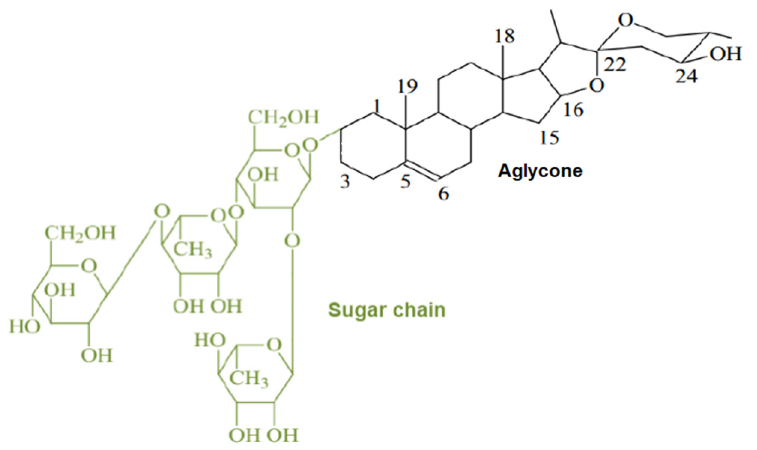
Figure 1. General structure of saponins.